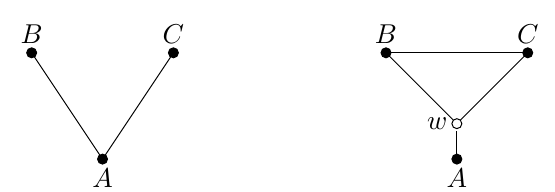
Figure 7 . Fork gadget. The interaction pattern on the left is simulated by the interaction pattern on the right.